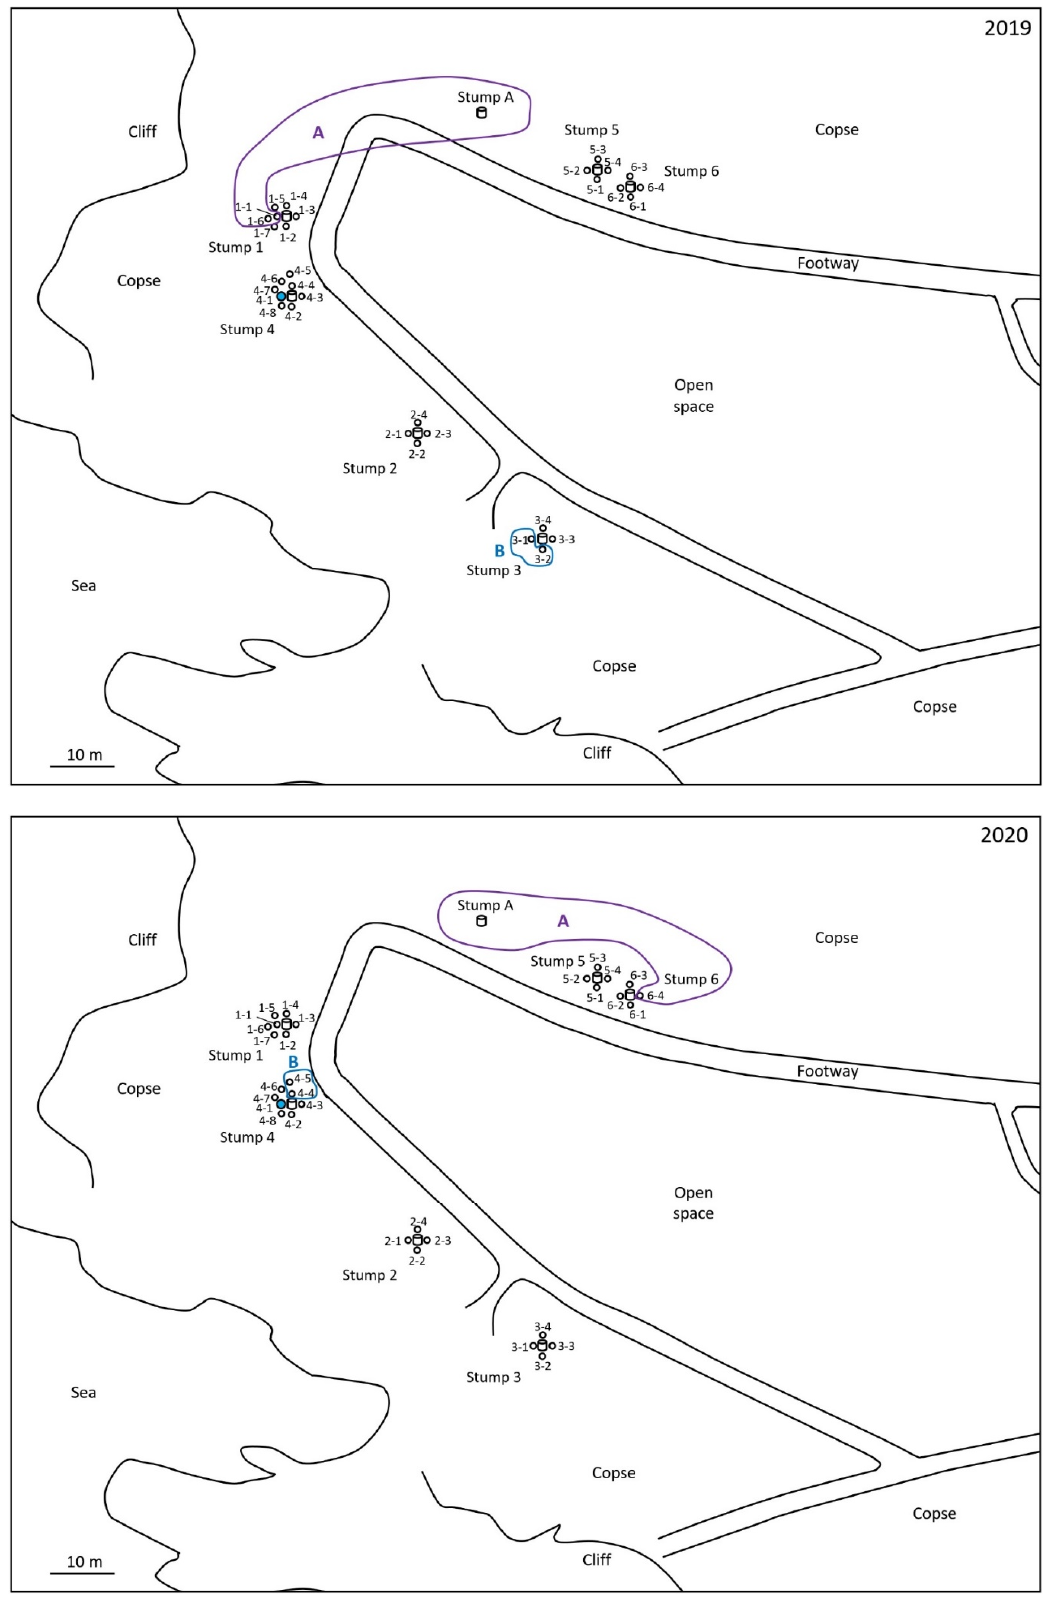
Figure 5. Location of monitoring stations occupied by Coptotermes formosanus in Isogi Park from 2016 to 2020. Stations with residing termites from the same population are encircled and labeled A and B. Station 4-1, around which discontinuous soil treatment was carried out, is highlighted in